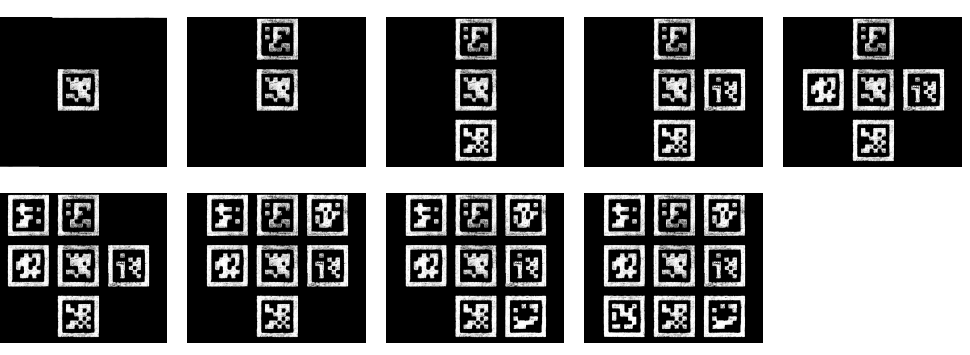
Figure A1. Images that are used for investigating the influences of QD (quad decimate), NT (number of threads), and the number of AprilTags in the field of view on the execution